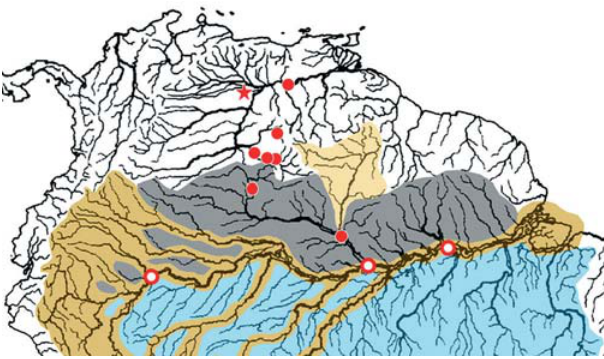
Fig. 11. Distributions of Leptodoras copei (solid circles, star denotes type locality) and L. cf. copei (open